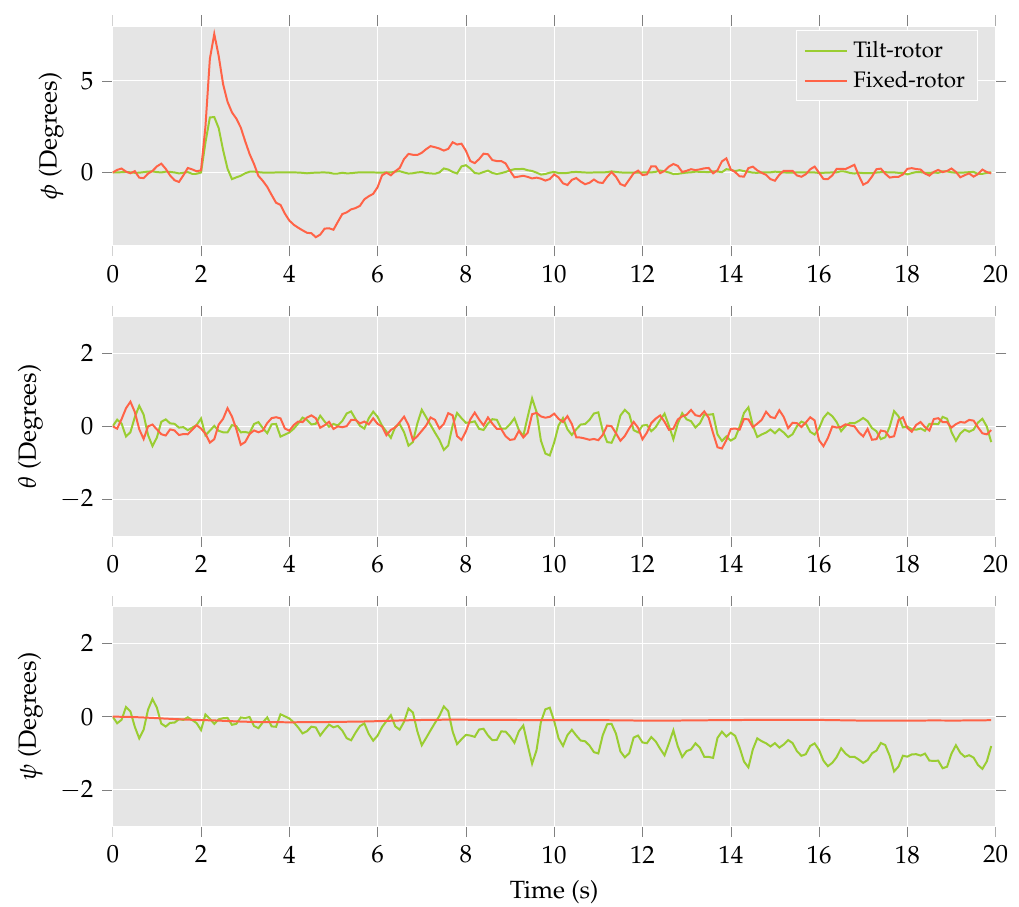
Figure 12. Multirotor helicopter attitude throughout the second maneuver.